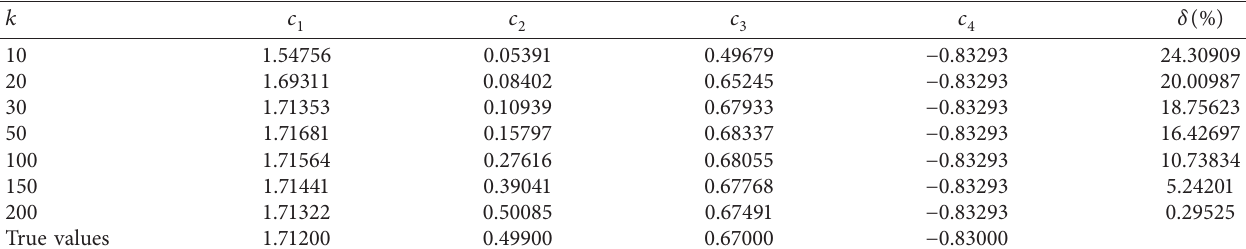
Table 2: The MT-GI estimates and errors with L � 20.